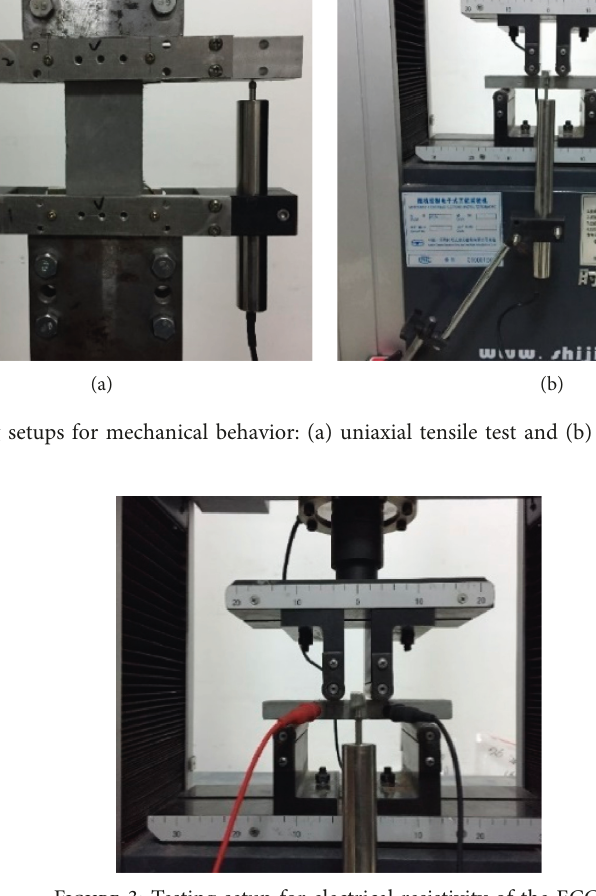
Figure 3: Testing setup for electrical resistivity of the